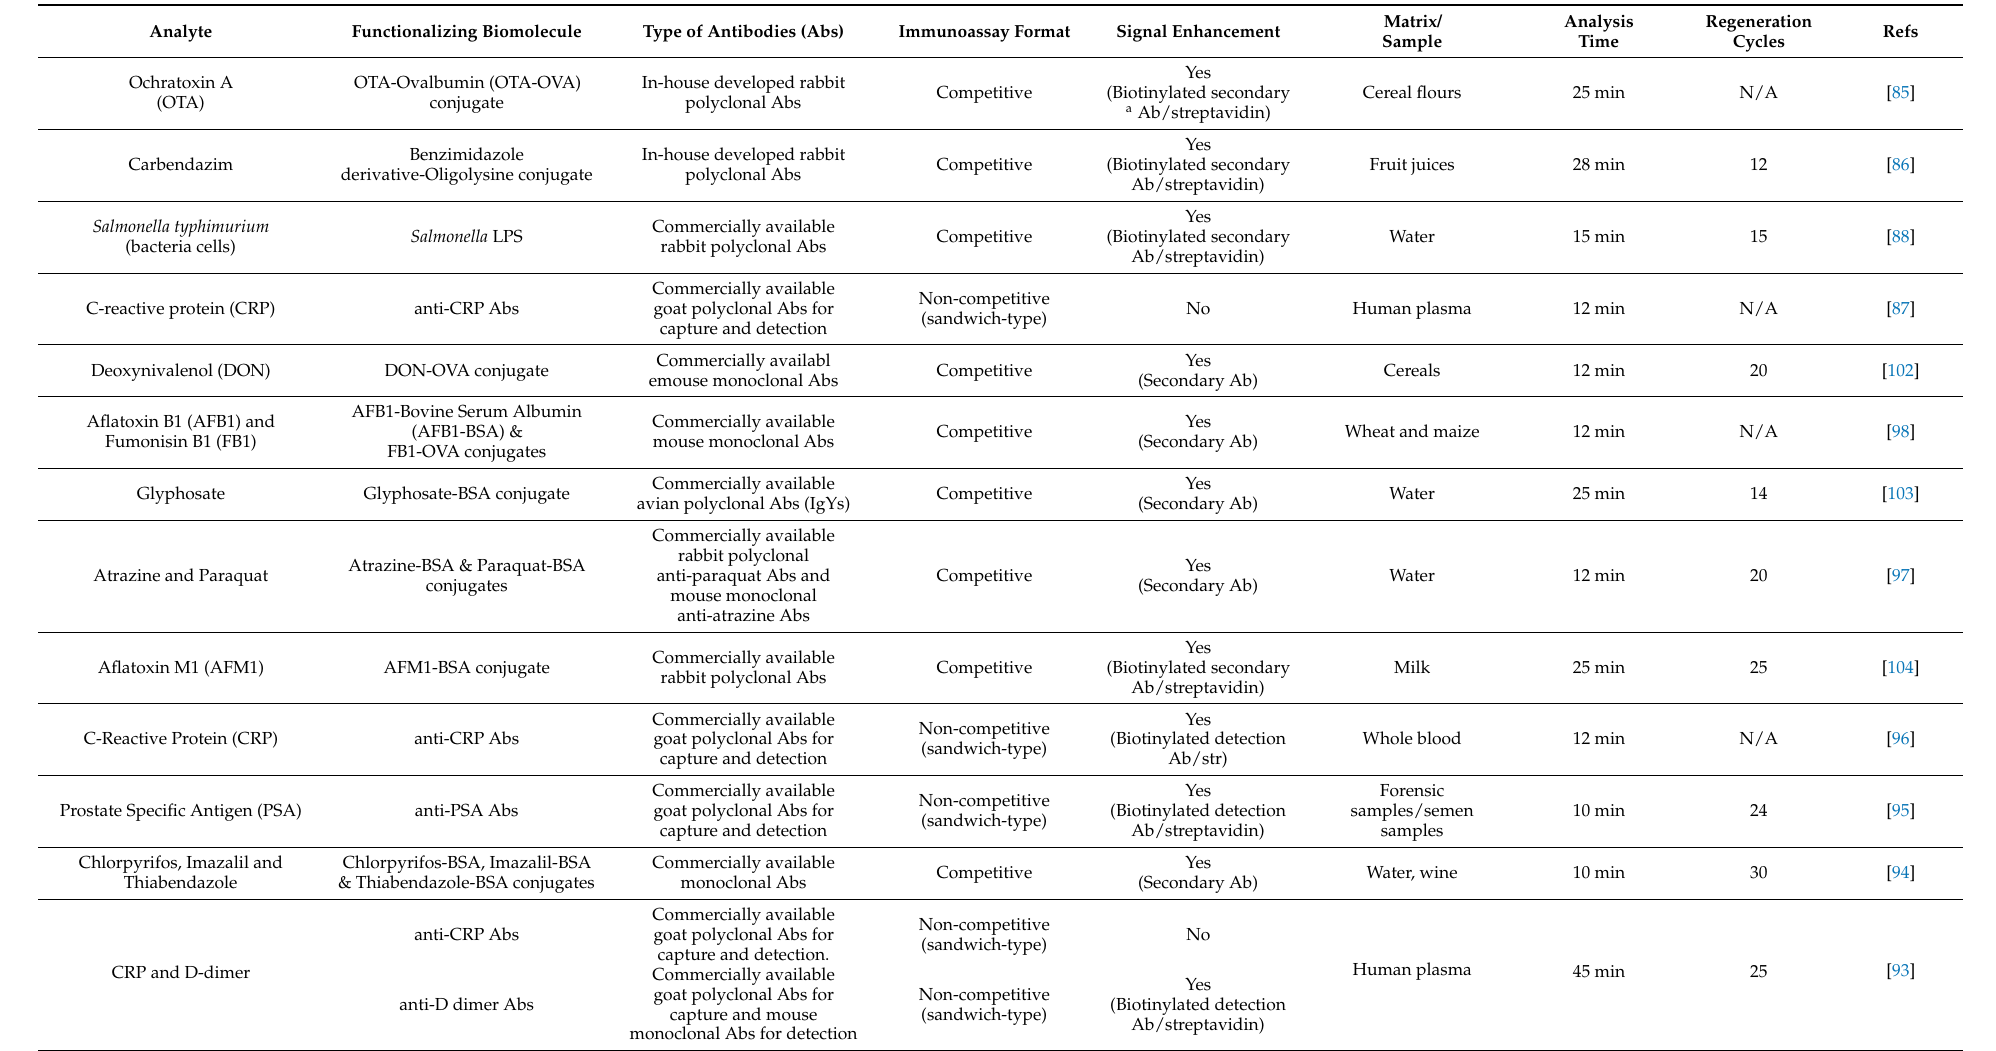
Table 2. Reports on WLRS-based immunosensors published in